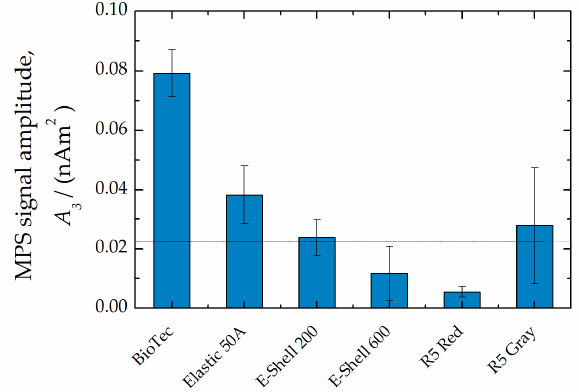
Figure 1. MPS signal of raw sample materials. The horizontal line denotes the threefold standard deviation of 100 blank measurements and defines the apparent limit of detection (LOD).